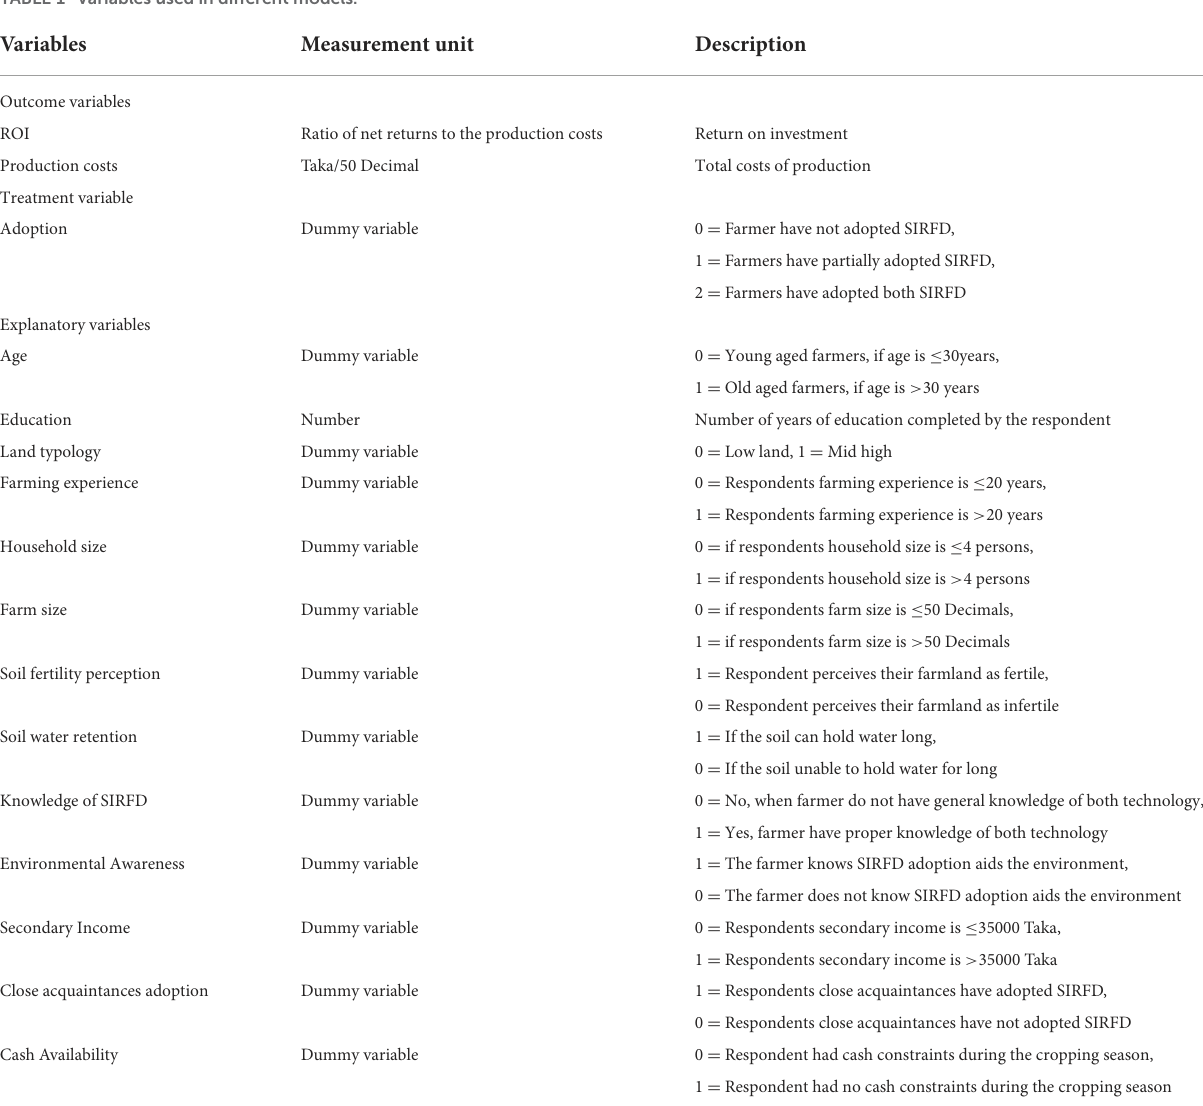
TABLE 1 Variables used in different